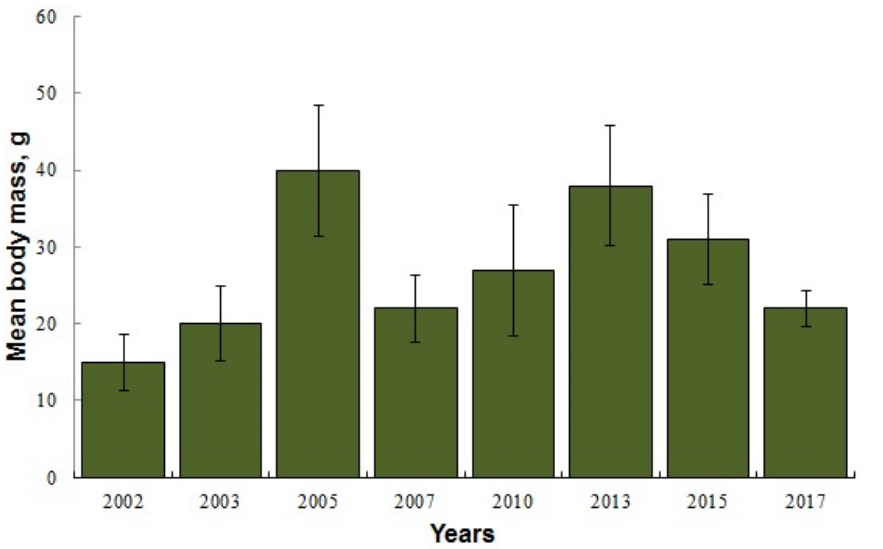
Figure 7. Overall mean body mass (g) of ice cod Arctogadus glacialis (±S.E.) across fjord and shelf stations in Northeast Greenland (cf. Table 1 and Figures 1 and 3). Only 2 specimens were caught in 2015.